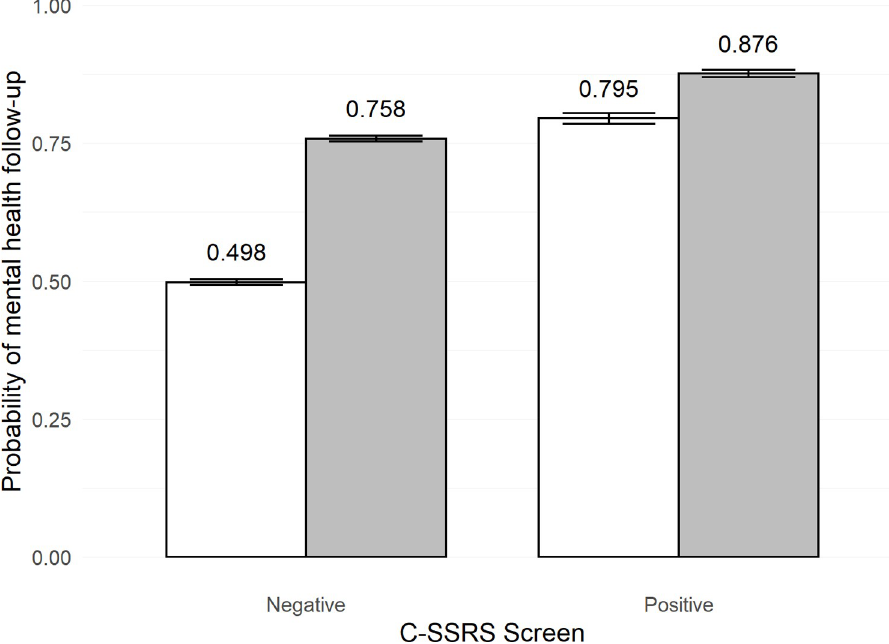
Fig 1. Probability of mental health follow-up after C-SSRS screening in fiscal year 2019. The gray bars represent having received mental health treatment in past year. The white bars represent not having received mental health treatment in the past year. Error bars represent standard error. C-SSRS = Columbia-Suicide Severity Rating Scale.